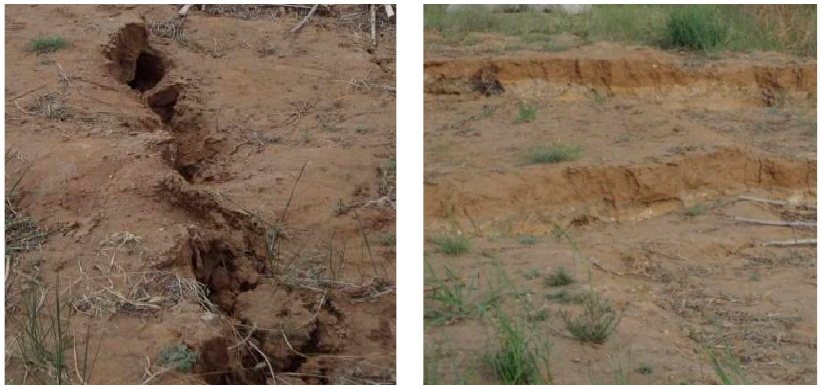
Figure 4. Vertical and horizontal movement of ground cracks.